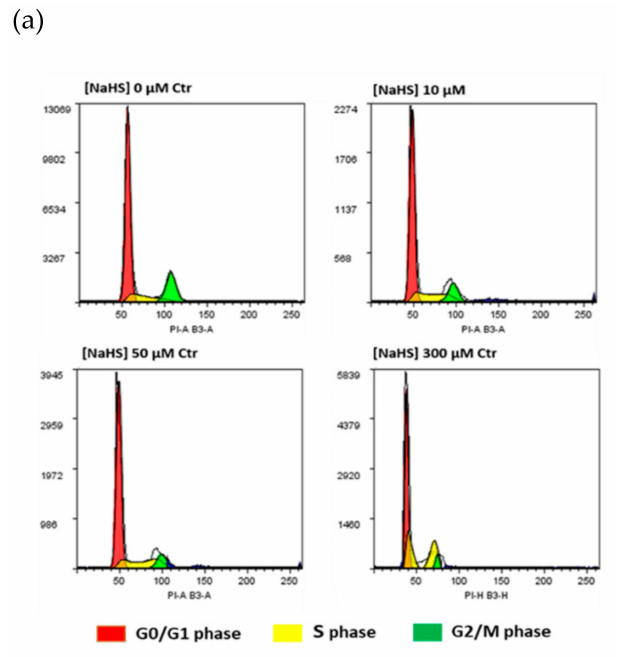
Figure 1. NaHS e ff ect on the vascular wall–mesenchymal stem cell (VW–MSC) viability. Cells were treated with di ff erent doses of NaHS for 24 h and cellular viability was measured by MTT assay (control (CTR) = DMSO 0.01% v / v ). ( a ) Data represent the mean ± S.D. of three independent experiments. ( b ) Representative images of cell morphology in the control cells and ( c ) after 24 h of NaHS 300 µ M treatment. Scale bar = 100 µ m